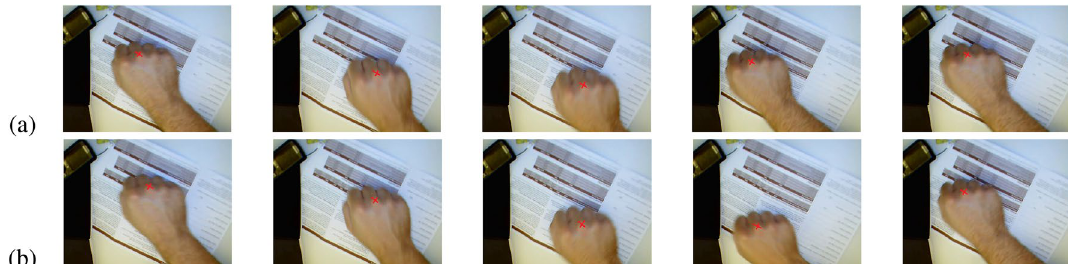
Figure 6. Clockwise circle. ( a ) Traditional clustering algorithms, ( b ) our clustering